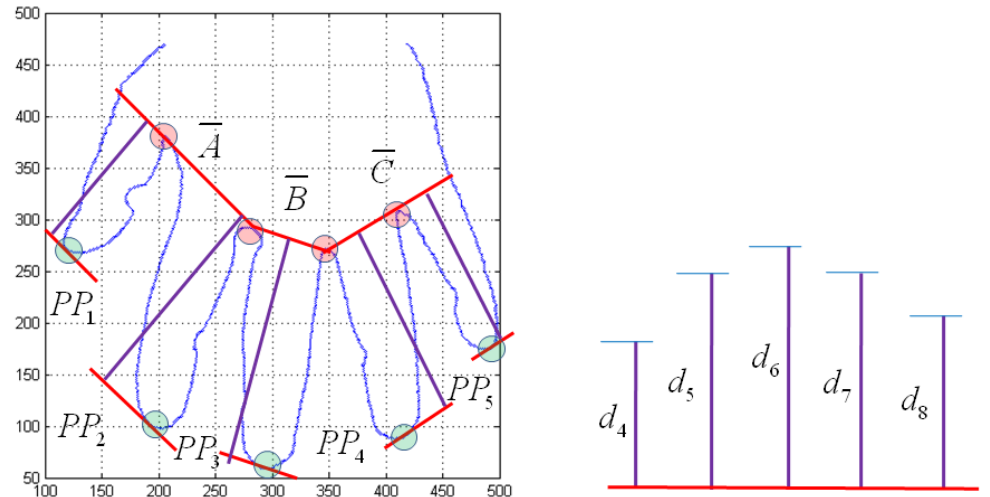
Figure 10. The feature extraction for the lengths of fingers.